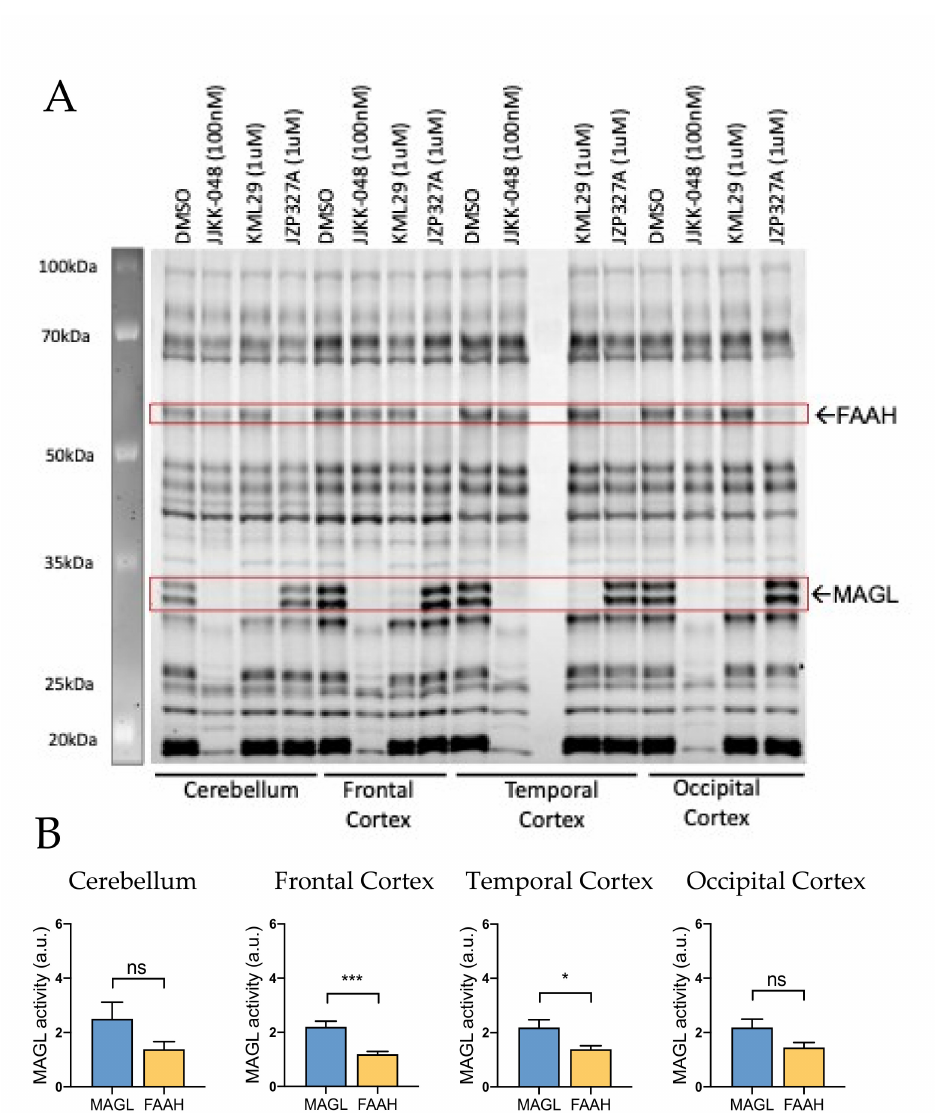
Figure 3. Competitive gel-based ABPP reveals MAGL and FAAH activity in rat cerebellum and cortex. ( A ) Cerebellar and frontal, temporal and occipital cortexes proteomes were incubated for 1 h with vehicle (DMSO), MAGL inhibitors JJKK-048 (100 nM) and KML29 (1 µ M) and FAAH inhibitor JZP327A (1 µ M), and then labeled with the fluorescent probe TAMRA-FP, as indicated in Materials and Methods. FAAH and MAGL were identified based on selective inhibition and their expected molecular weights. Both MAGL and FAAH activities were high in the cerebellum and cortex. ( B ) Histograms showing the basal activity of MAGL and FAAH in the cerebellum and frontal, temporal and occipital cortexes. Basal MAGL activity was ~2-fold higher compared to that of FAAH in frontal and temporal cortexes. In contrast, MAGL and FAAH activities were not found statistically different in samples of the cerebellum and occipital cortex. Unpaired t-test, * p < 0.05, *** p < 0.001, ns = nonsignificant, n =